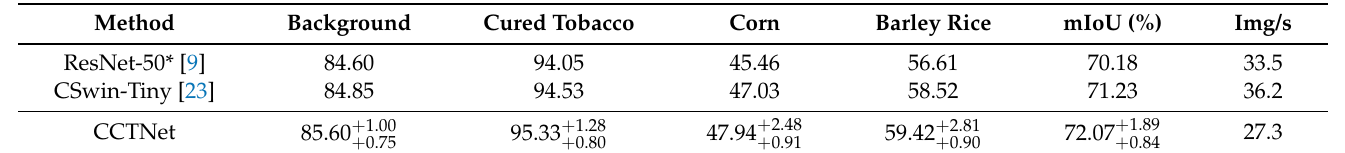
Table 8. IoU scores of each category on the Barley Remote Sensing